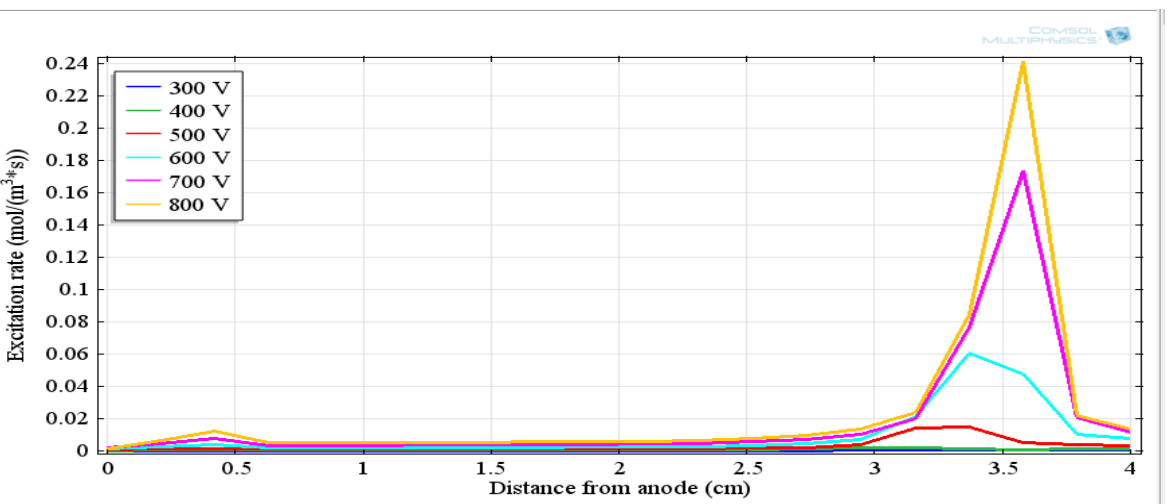
Fig. 12: Excitation rate as a function distance from anode at different discharge